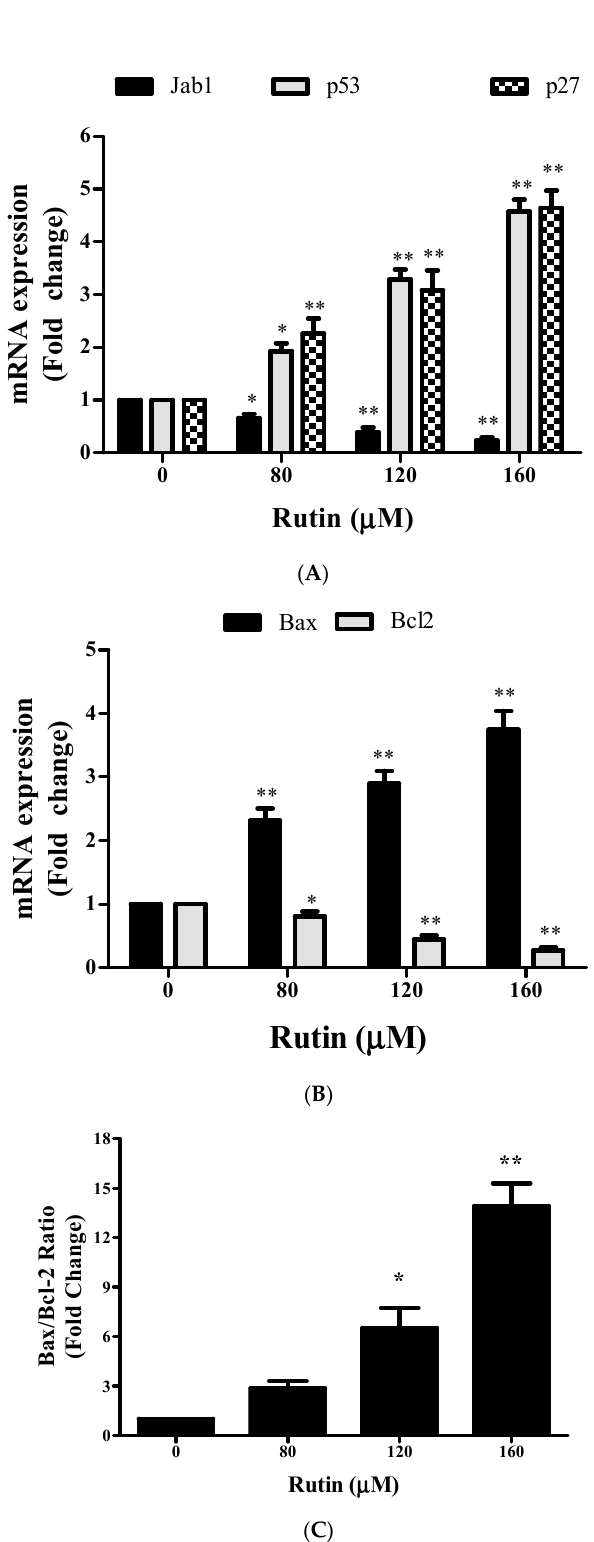
Figure 2. Effect of rutin on gene expression of mRNA expression of target genes. ( A ) The mRNA expression of Jab1 , p27 , and p53 in rutin-treated SiHa cells (80, 120, and 160 µM) was investigated by qRT PCR. ( B ) The mRNA expression of proapoptotic gene Bax , antiapoptotic gene Bcl2, and ( C ) Bax /Bcl2 ratio in cervical cancer cells treated with rutin (80, 120, and 160 µM) was investigated by qRT PCR. The results are represented as mean ± SEM of three independent experiments (* p < 0.01, ** p < 0.001 compared with control group).